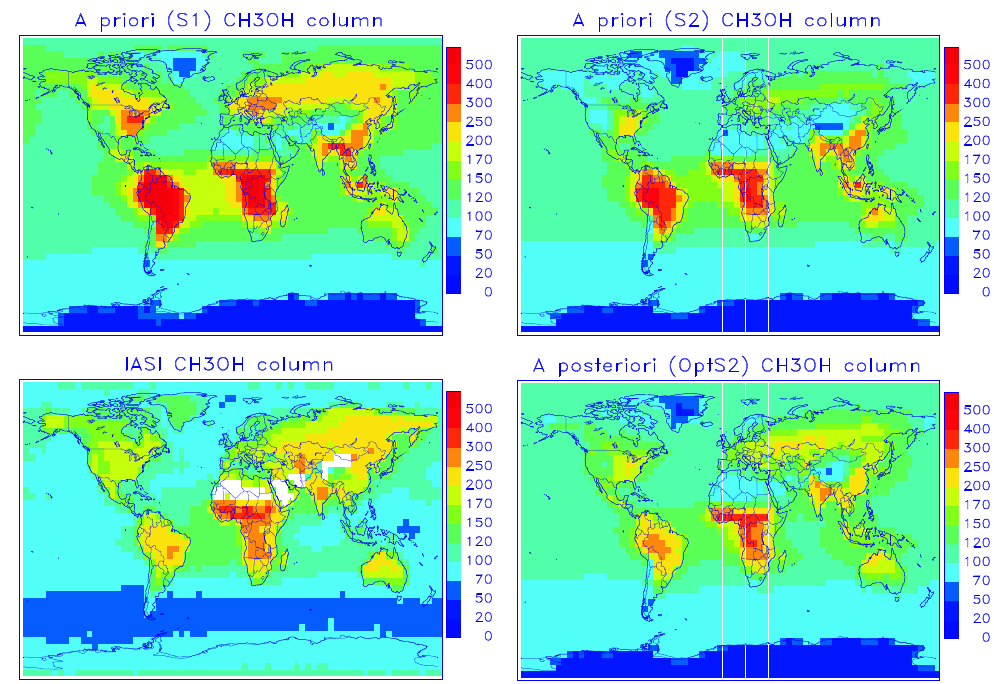
Fig. 3. Top panels : A priori global maps of annually averaged methanol columns simulated in S1 and S2 (Table 1). Bottom left : IASI yearly averaged methanol column abundances for 2009 gridded onto a 4 ◦ × 5 ◦ horizontal resolution. Blanks correspond to regions where the quality of the retrievals might be doubtful, mainly due to emissivity problems (Razavi et al., 2011). Bottom right : Methanol columns inferred from the OptS2 inversion study (Table 1). Units are 10 14 molec.cm − 2 . Note that modelled columns account for IASI averaging kernels. 51